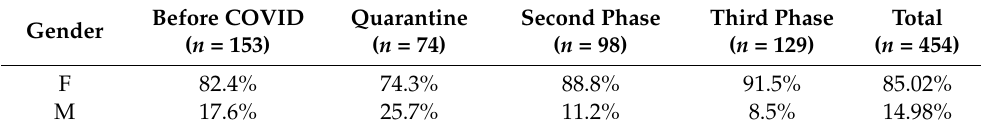
Table 2. Gender by group.